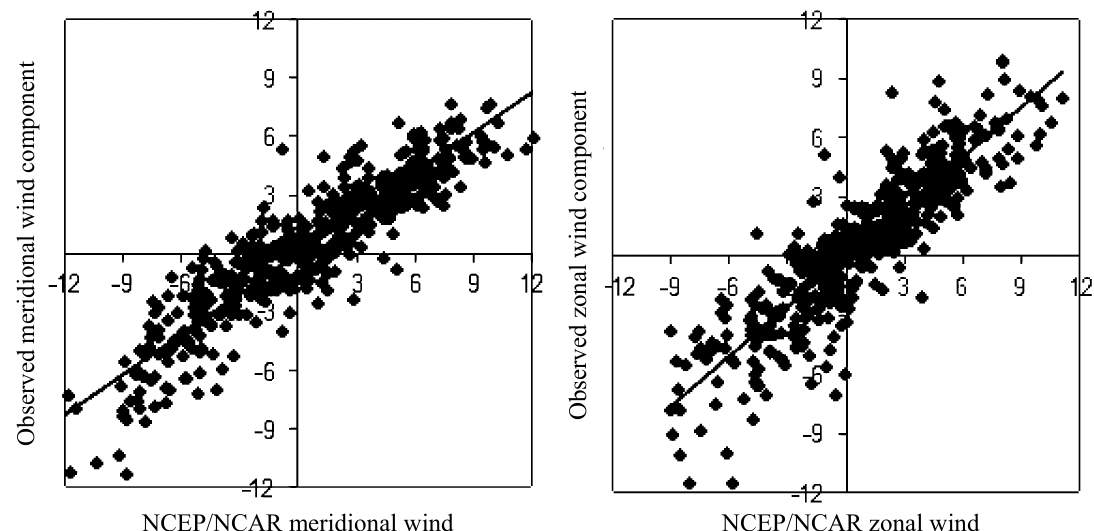
Fig. 2. Wind data from the NCEP/NCAR reanalysis and observed data from